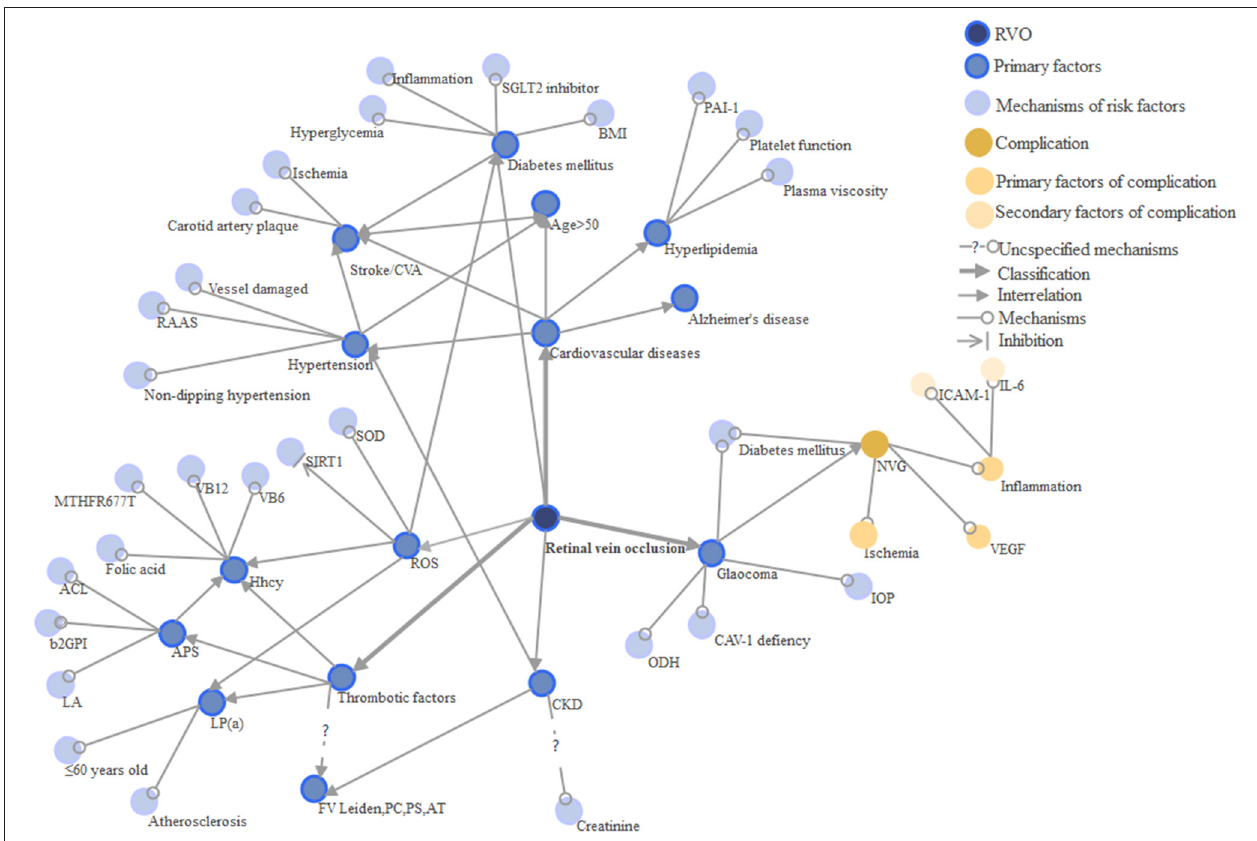
FIGURE 3 | Relationships between risk factors and RVO.